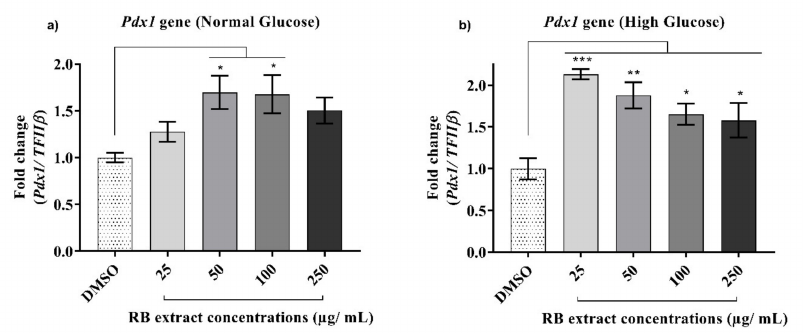
Figure 3. E ff ect of RB phenolic extracts on the expression of the Pdx1 gene under normal and high glucose conditions in INS-1E cells. ( a ) Normal glucose conditions, ( b ) High glucose conditions ( n = 5). The level of significance is indicated by the asterisks, whereby * p < 0.05, ** p < 0.01, *** p < 0.001. Data are presented as Mean ± SD. Dimethyl sulfoxide, DMSO; Insulin promoter factor 1, Pdx1 ; Insulin-secreting rat insulinoma cell, INS-1E; Rice bran,